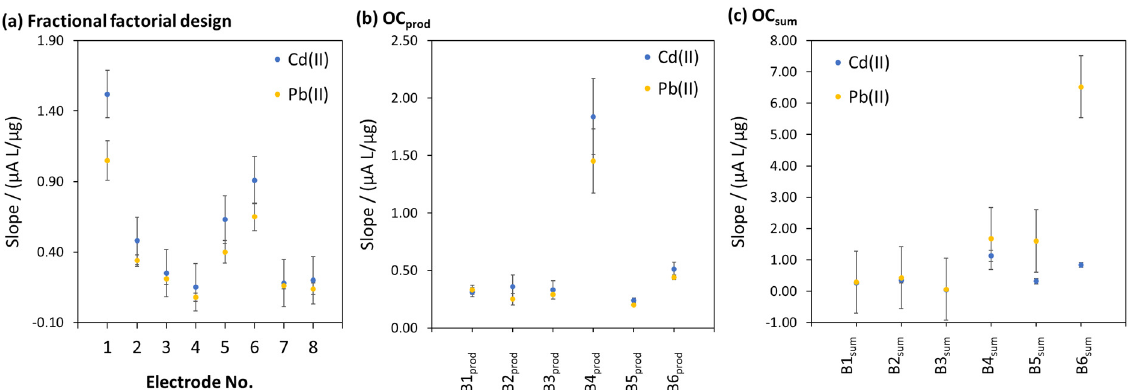
Figure 3. Sensitivity determined for Cd(II) and Pb(II) during the course of ( a ) fractional factorial design testing, ( b ) simplex optimization where the optimization criteria is OC prod , and ( c ) simplex optimization where the optimization criteria is OC sum . The error bars represent standard deviations.